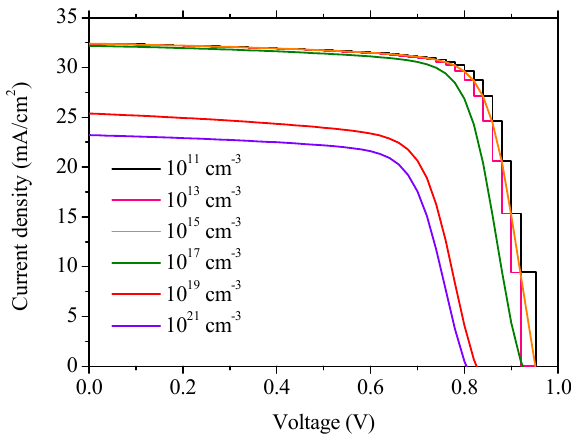
Figure 10. Effect of IL1 defect density on J-V characteristics. Figure 10. E ff ect of IL1 defect density on J-V characteristics.